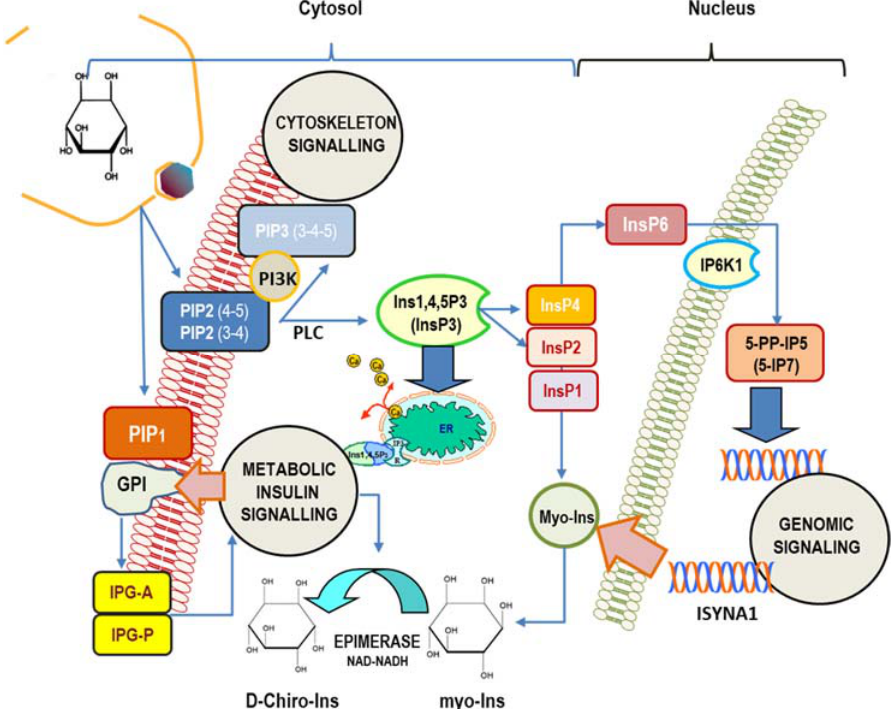
Figure 1. Main intracellular signaling pathways in which myo-inositol participates. Inositol is mostly involved in (1) cytoskeleton remodeling; (2) insulin transduction (noticeably through inositol-phosphoglycan containing myo-Ins (IPG-A) and D-Chiro-Ins (IPG-P) released from GPI (glycosylphosphatidylinositol-anchored proteins) and glucose metabolism); (3) genomic signaling, especially through the participation of inositol hexakisphosphate (InsP6) and pyrophosphates. In addition, myo-Ins—and its isomer D-Chiro-Ins—exert relevant effects upon the steroidogenic pathway in ovary cells. Cellular myo-Ins is supplied by external uptake and endogenously synthesized by ISYNA1 gene. PIP2 (3-4), 1-Phosphatidyl-1D-myo-inositol 3,4-bisphosphate; PIP2(4-5), 1-Phosphatidyl-D-myo-inositol 4,5-bisphosphate. PIP1,